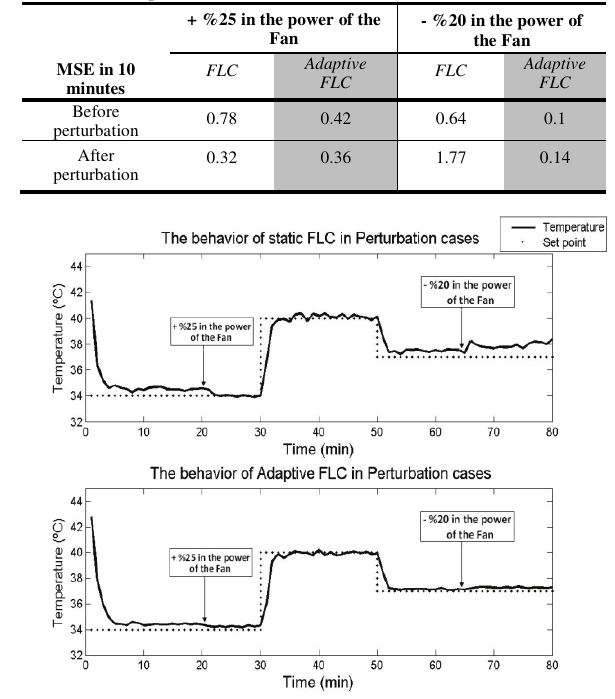
Fig. 6. The perturbation effects on the control